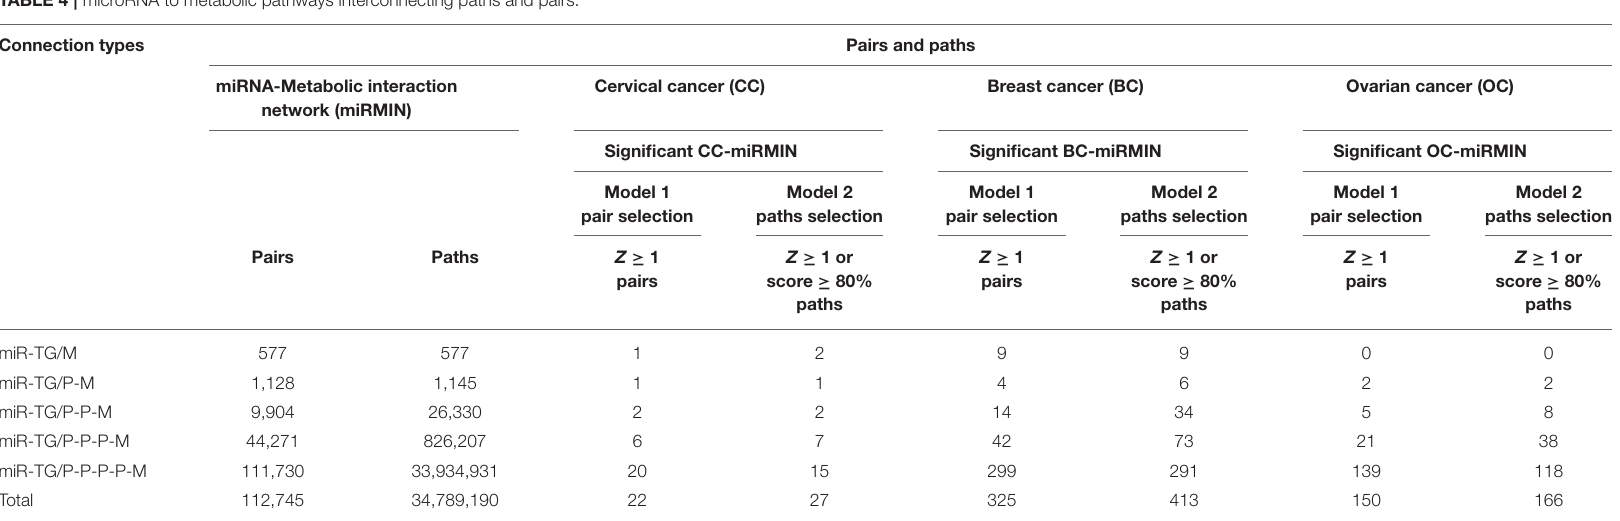
TABLE 4 | microRNA to metabolic pathways interconnecting paths and